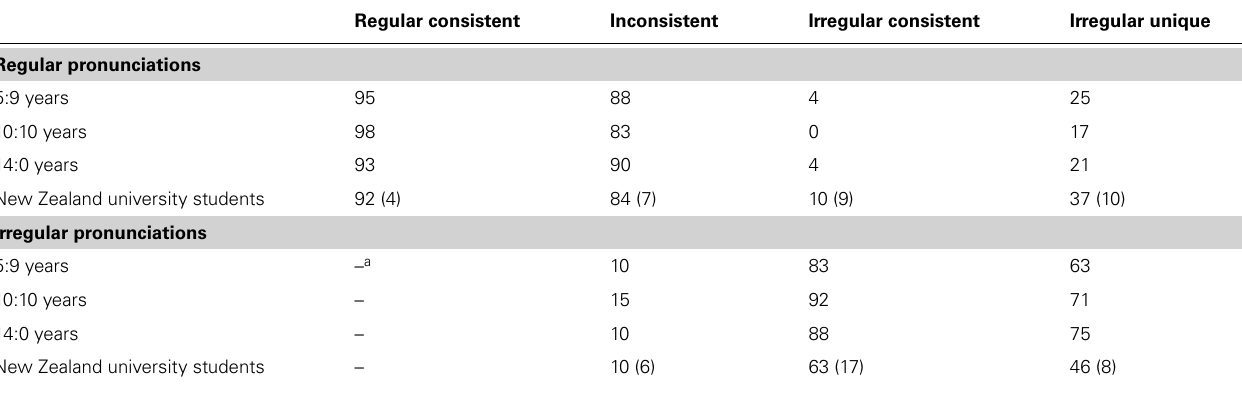
Table 3 | Experiment 2: Mean percentage of regular and irregular pronunciations forAndrews and Scarratt nonwords varying in regularity and consistency of body spelling for Maxine at 5:9, 10:10, and 14:0, and for the New Zealand university students without phonics instruction (standard deviation in parenthesis).